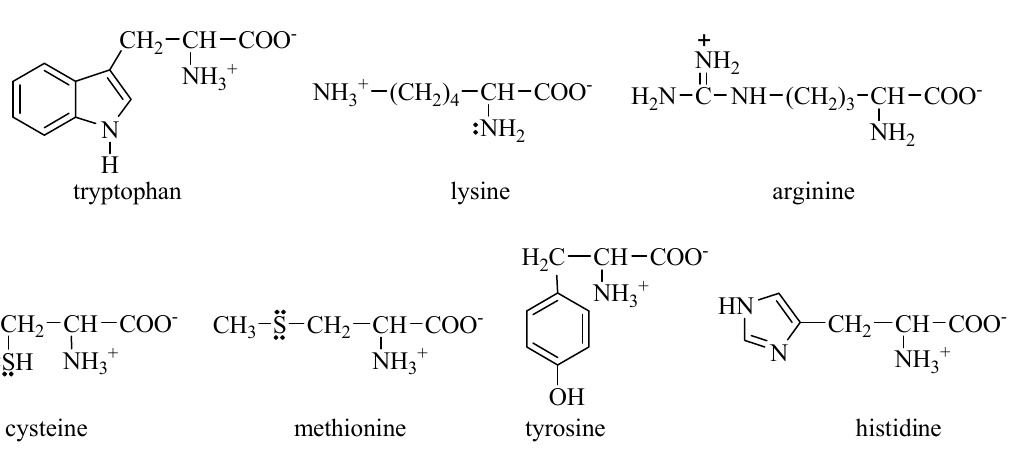
Figure 3. Amino acids with strong antioxidant ability.